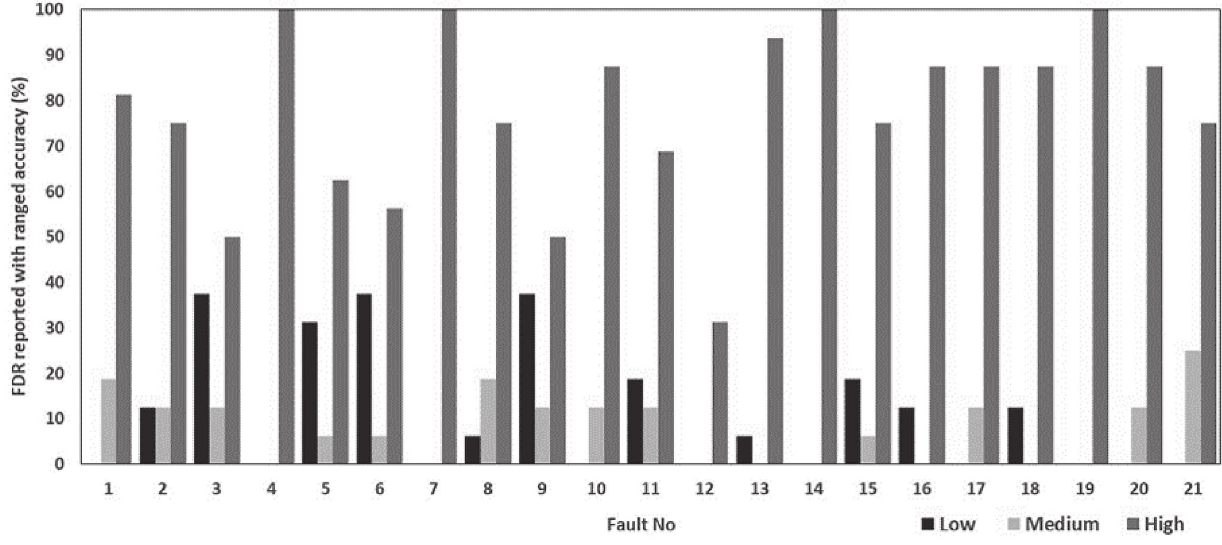
Fig. 4 – Graph of FDR reported for all 21